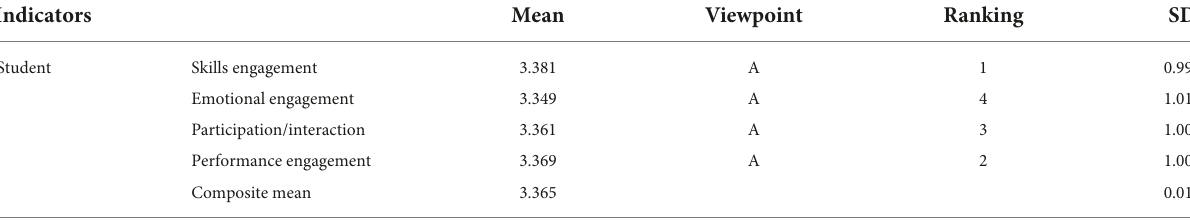
TABLE 2 Level of engagement of computer science college students.